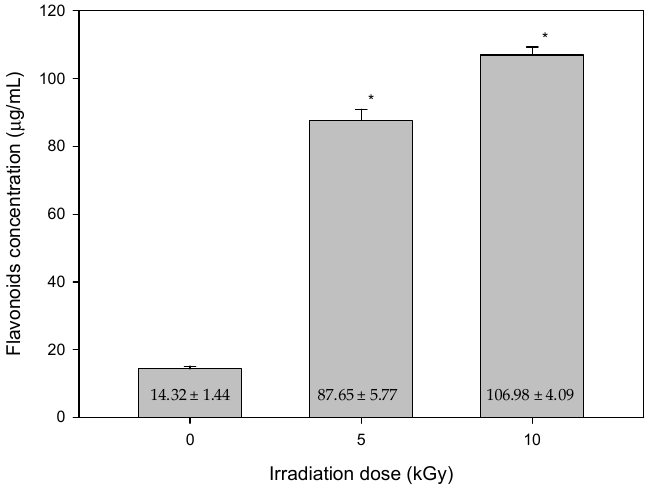
Figure 4. The measurements of total flavonoids of non-irradiated (0 kGy) and irradiated (5 or 10 kGy) mung beans. (mean ± standard deviation, * p < 0.001; N = 20/group).